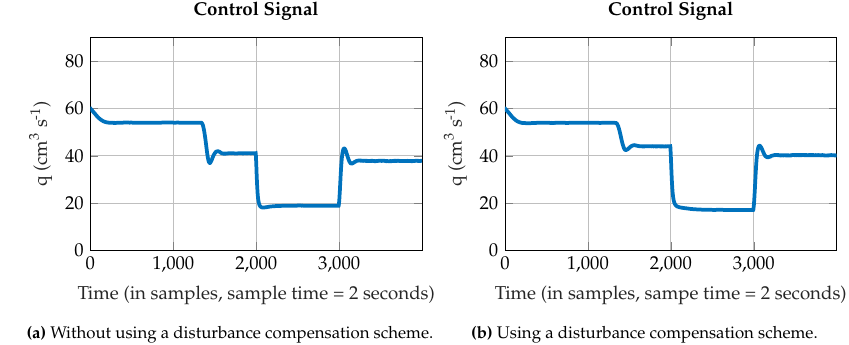
(b) Using a disturbance compensation scheme. Figure 11. Closed-loop performance of the Coupled Tanks Liquid Level Control system for several operation setpoints, for ρ = 5.